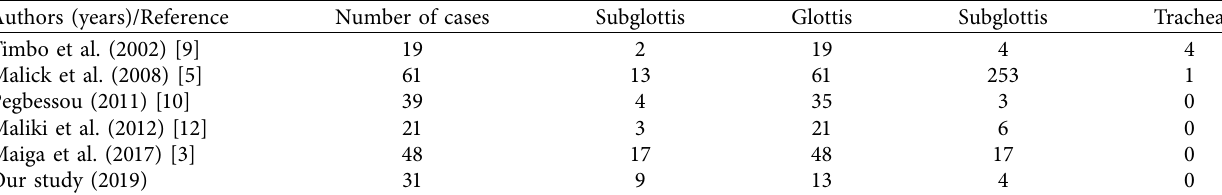
Table 1: Different locations of papillomas according to the